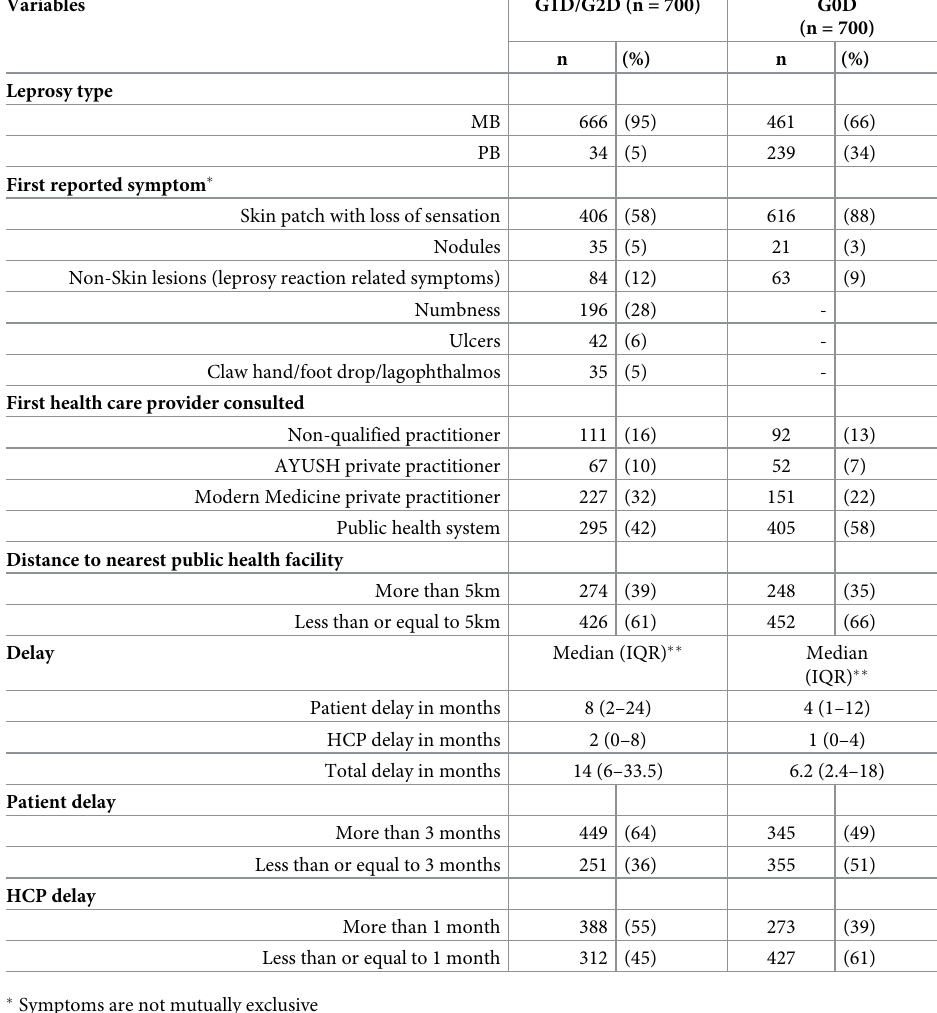
Table 2. Disease related factors among G1D/G2D (cases) and G0D (controls) studied in the 5 states of India dur- ing 2014–2016.